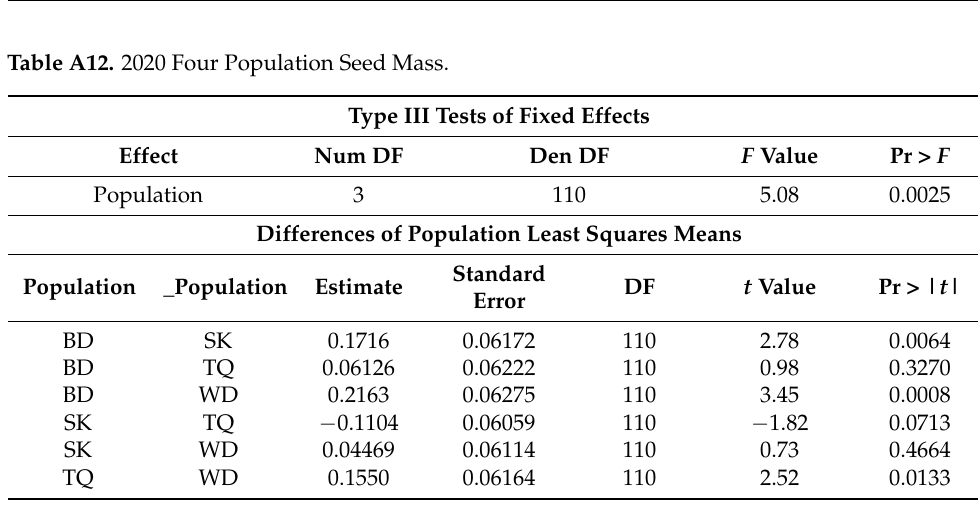
Table A13. 2019 Four Population Fertilization